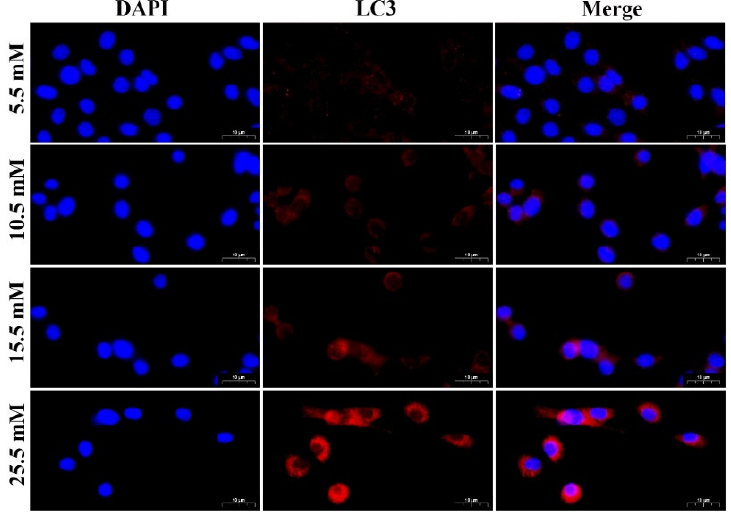
Figure 2. The fluorescence distribution of LC3 in MDBK cells after different concentrations of glucose stimulation. MDBK cells were treated with 5.5, 10.5, 15.5, and 25.5 mM glucose for 24 h, respectively. LC3 was labeled with red fluorescence by Cy3, and the nucleus was labeled with blue fluorescence by DAPI. Scale bar, 10 µm.